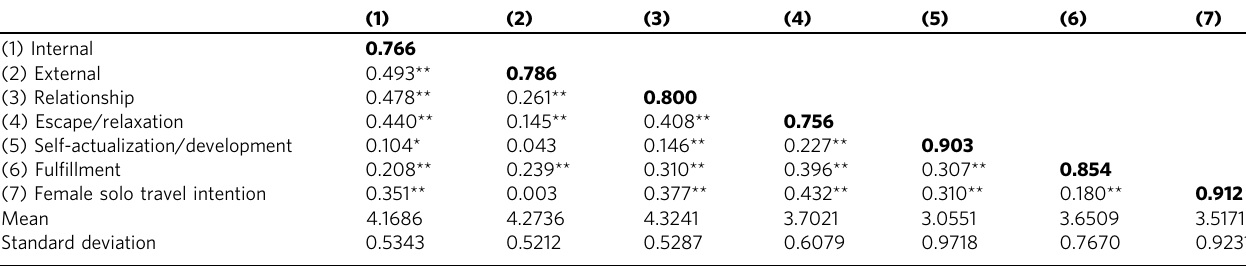
Table 6 Fornell – Larcker criterion analysis of the